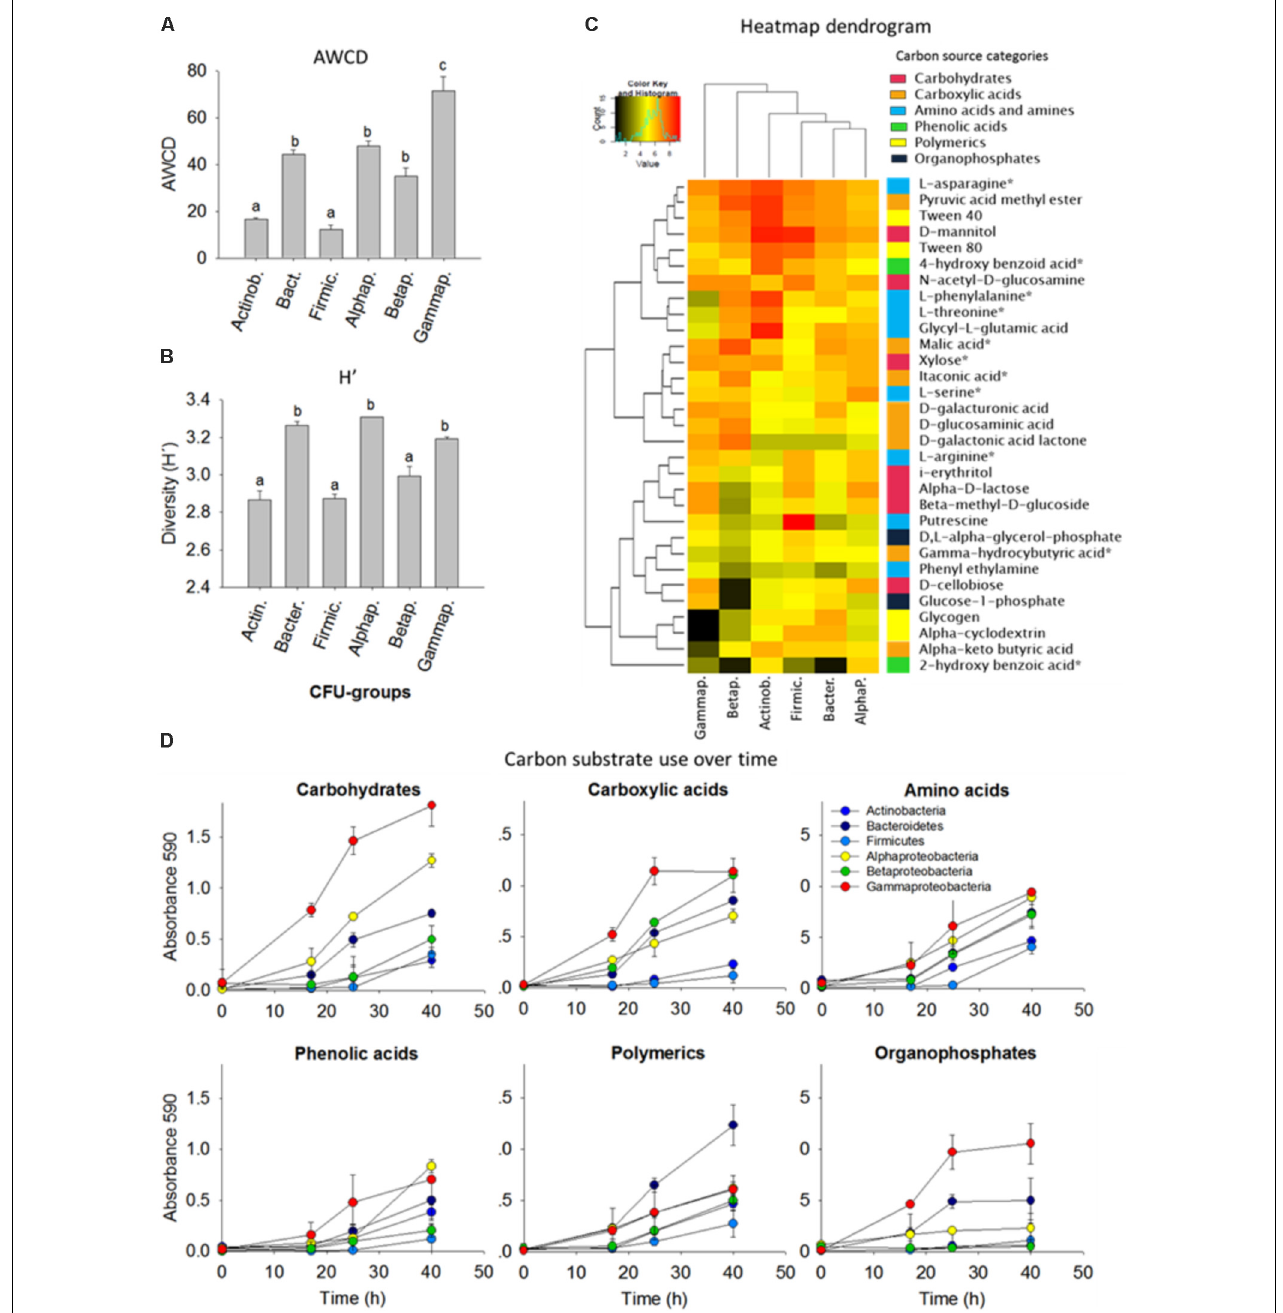
FIGURE 3 | Comparison of carbon substrate utilization activities of isolated colony forming units (CFUs). (A) Average well color density (AWCD) (mean ± standard error bars) for carbon substrate utilization. (B) Diversity of carbon substrate use as judged by the Shannon index (H’). Different letters (a,b,c) indicate that the means are significantly different (ANOVA, Tukey HSD, p < 0.05, n = 3). (C) Heatmap dendrogram of the carbon substrate utilization based on the area under the absorbance versus time curve AAT/AWCD. Columns represent the bacterial phyla, in rows are the 31 carbon sources. The colored side-bar shows the categories to which the carbon sources belong. Carbon sources with an asterisk are common root exudates. (D) Carbon substrate use over time. 10 isolates were grouped per phyla/class and included for the Actinobacteria ( Arthrobacter , n = 3; Curtobacterium ; Microbacterium ; Nocardia ; Nocardioides; Rhodococcus , n = 2; Streptomyces ), Bacteroidetes ( Chryseobacterium , n = 3; Dyadobacter ; Flavobacterium , n = 2; Mucilaginibacter ), Firmicutes ( Bacillus , n = 4; Lysinibacillus , n = 2; Paenibacillus , n = 3; Planococcaceae), Alphaproteobacteria ( Ensifer ; Kaistia ; Novosphingobium ; Paracoccus ; Phyllobacterium ; Rhizobium ; Sinorhizobium ; Sphingobium , n =